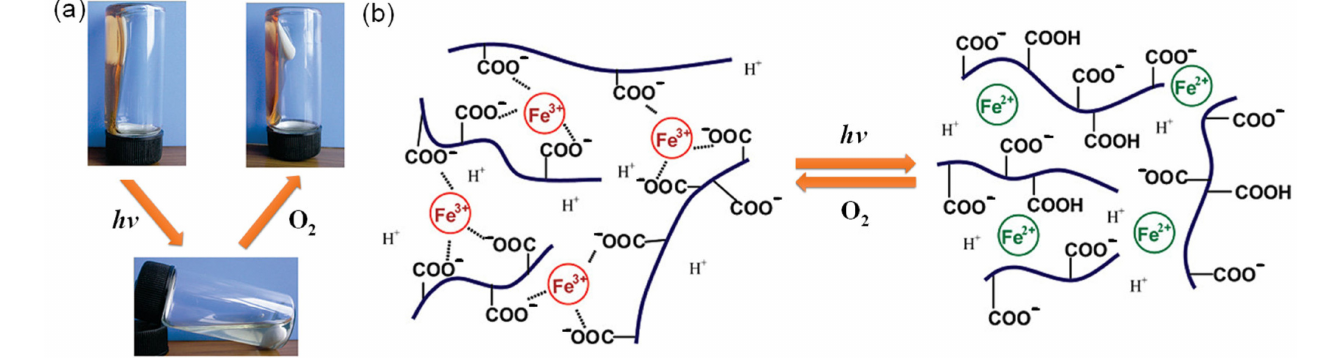
Figure 13. ( a ) Switching gel − sol − gel transition in PAA (20 wt%) + Fe(III) (0.02 mol/L) − citrate (0.04 mol/L) aqueous system at pH 4.0 and room temperature. ( b ) Schematic illustration of the gel − sol transition in the PAA + Fe(III) − citrate aqueous system switched via photoreduction and oxidation. Reprinted with permission from Ref. [63]. Copyright (2008), American Chemical